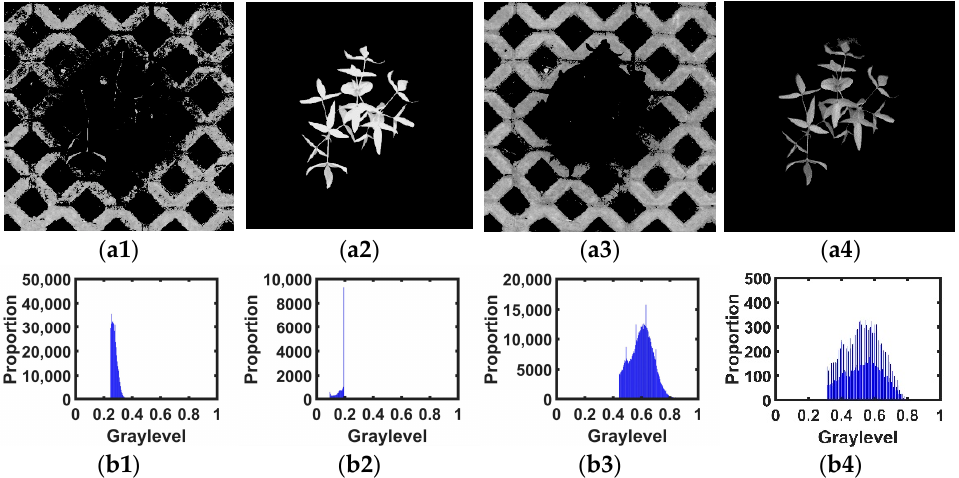
Figure 10. Extraction effect and corresponding histograms under drought treatment: ( a1 ) GRE target image, ( a2 ) NIR target image, ( a3 ) RED target image, ( a4 ) REG target image, ( b1 ) GRE histogram, ( b2 ) NIR histogram, ( b3 ) RED histogram and ( b4 ) REG histogram.